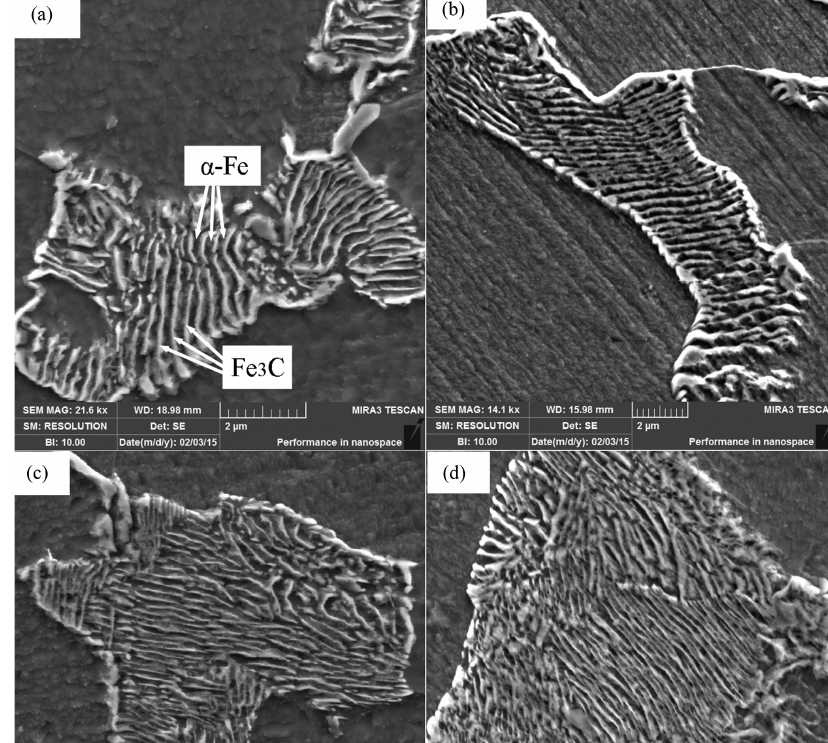
Figure 2: The morphology of lamellar pearlite in tested steels: (a) without Ce, (b) 0.0014% Ce, (c) 0.0020% Ce, (d) 0.0025%